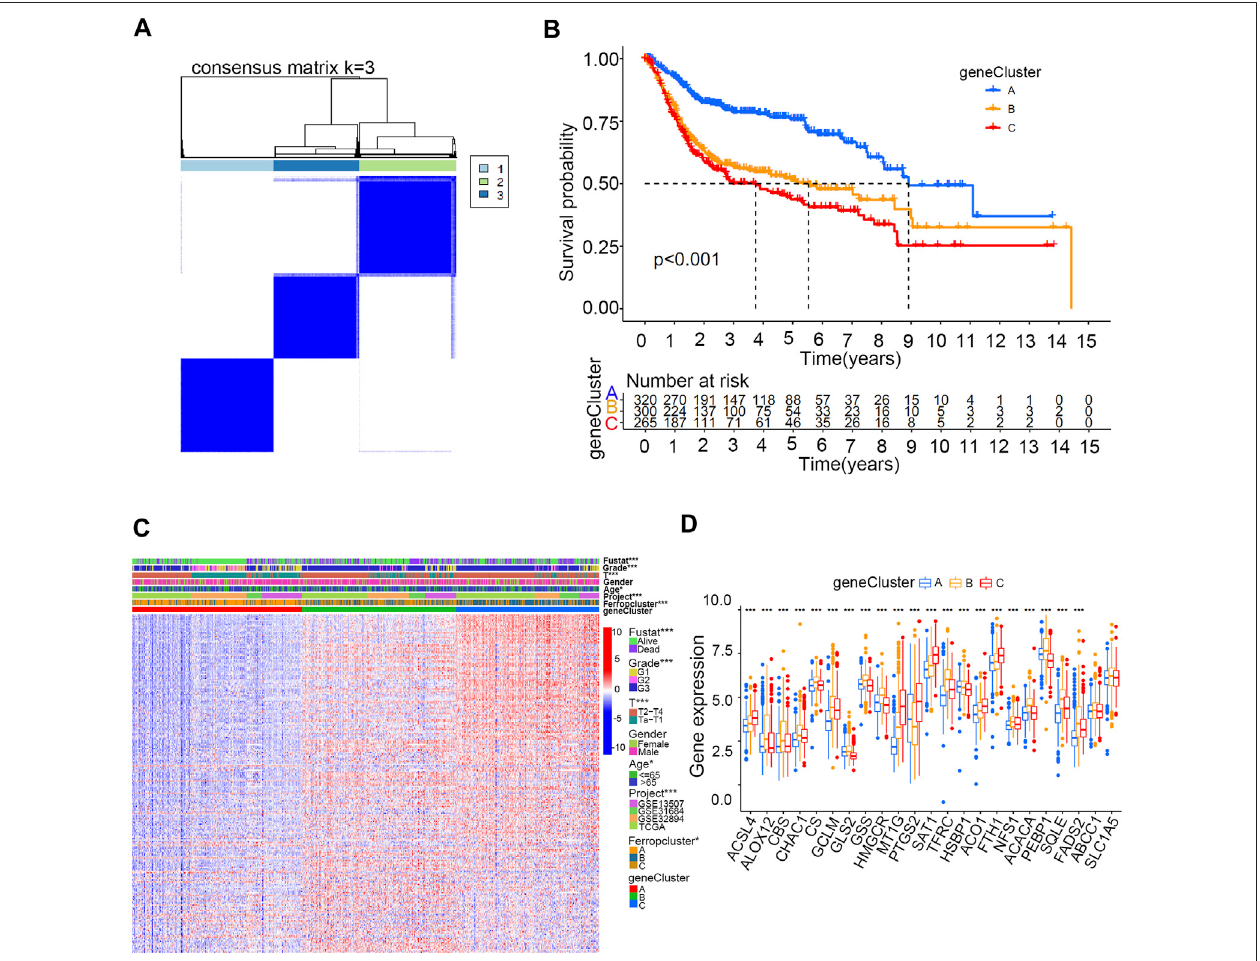
FIGURE4| Ferroptosisgeneclustersinthemergedcohort. (A) Consensusclusteringmatrixfork=3. (B) Kaplan – Meiercurvesurvivalanalysisamongthreedistinct gene clusters. (C) Heatmap demonstrating various clinicopathological features of three distinct m6A clusters. (D) Different expression levels of 23 ferroptosis-related genes in distinct gene clusters. The asterisk symbol indicates the statistical p -value. (* p < 0.05; ** p < 0.01; *** p < 0.001).